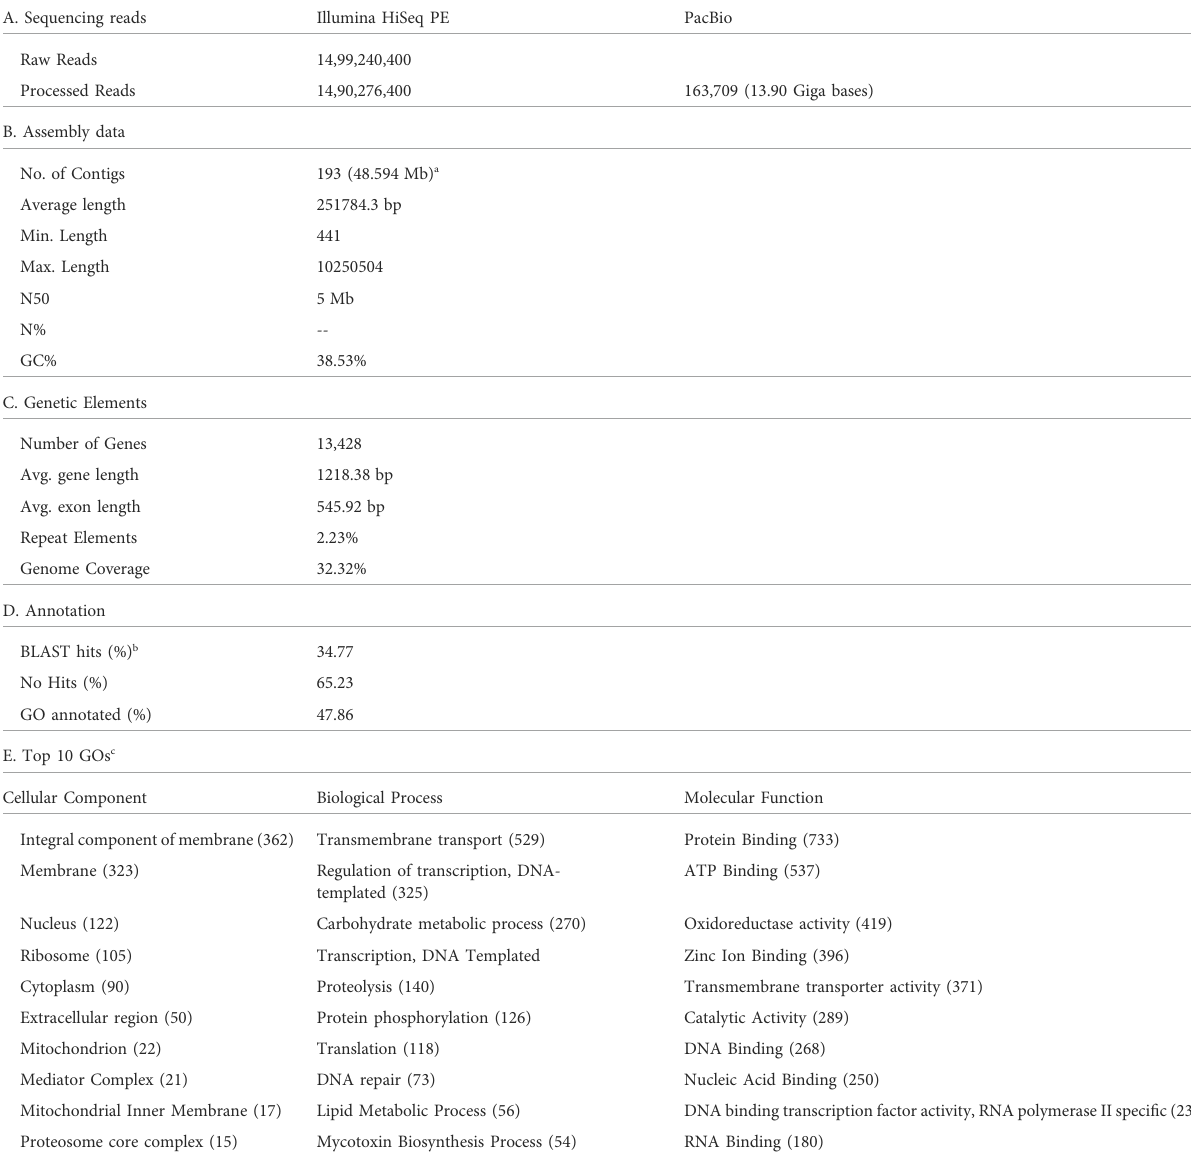
TABLE 1 Sequencing summary statistics of C. aff. paspali genome (H3